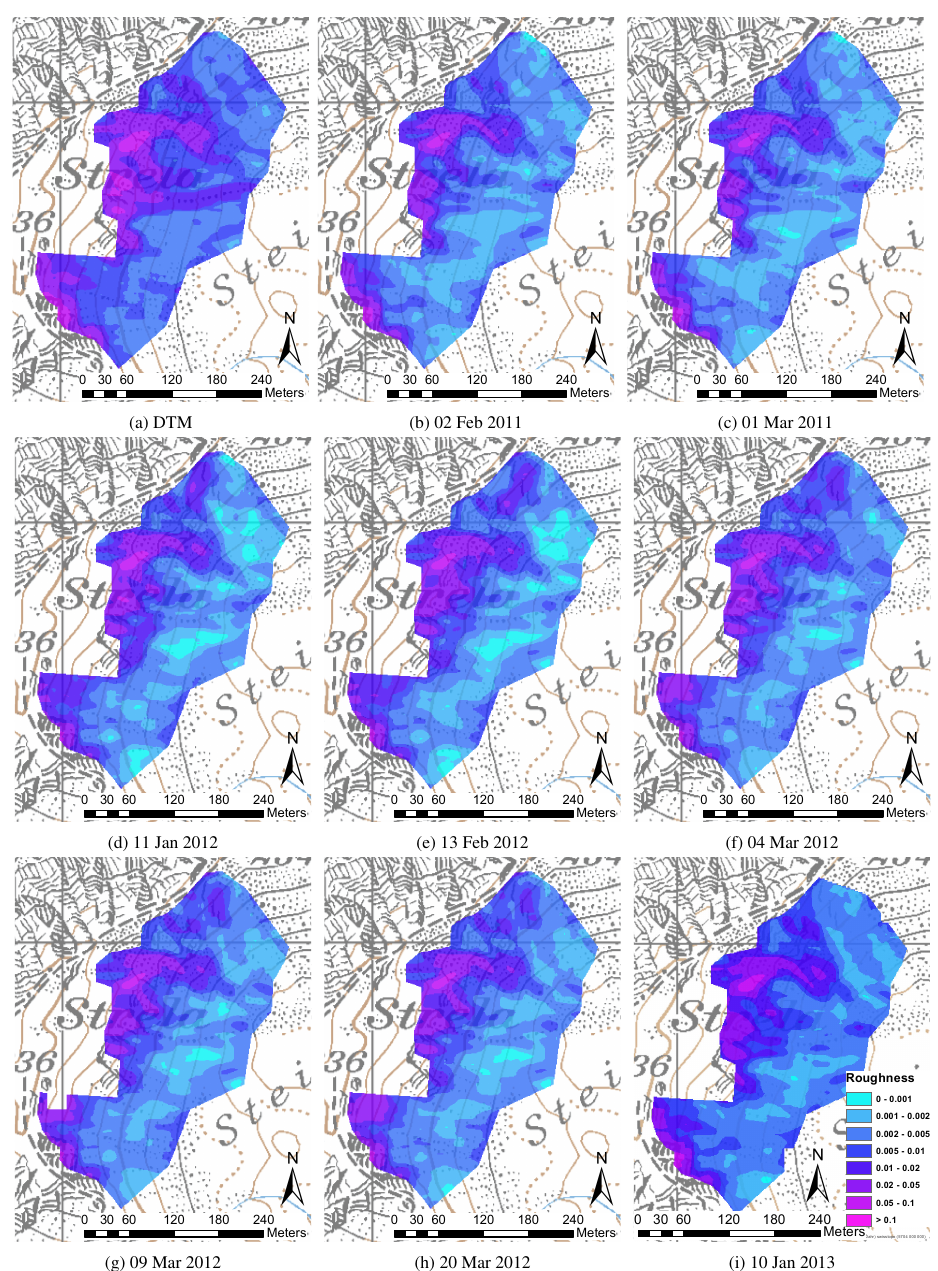
Fig. A3. Surface roughness of summer terrain and winter terrain at a scale of 25m in the basin ST. Pixmaps © 2013 swisstopo (5704 000 000).